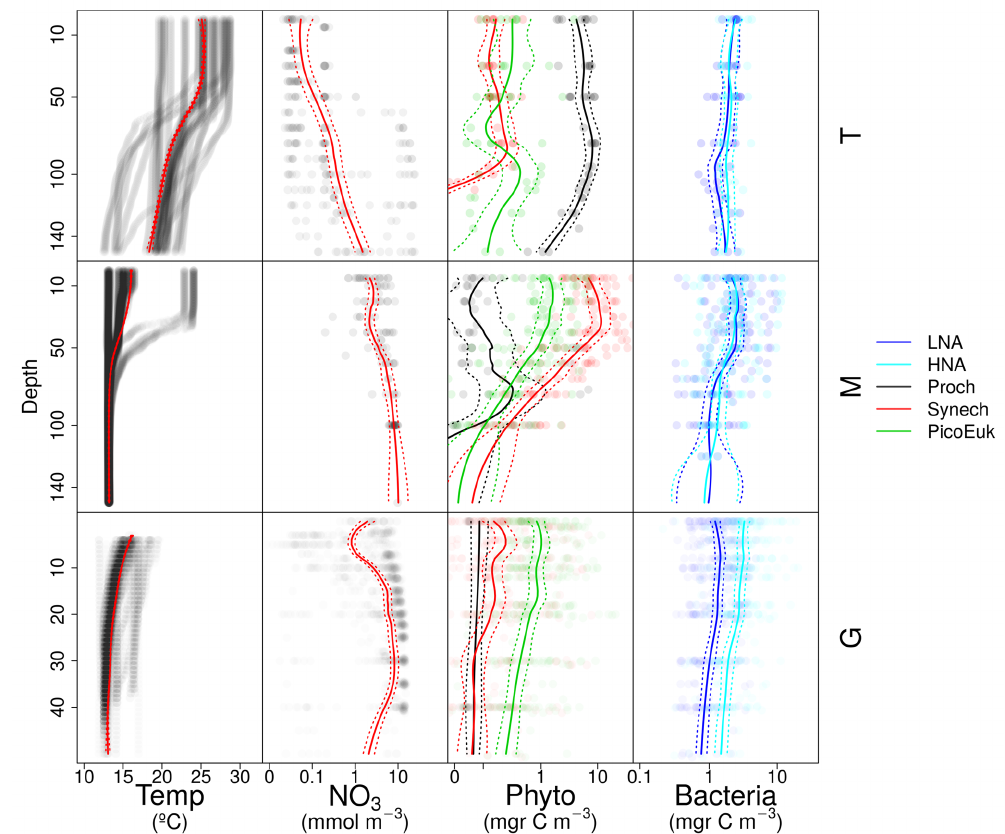
Figure A3. Vertical distribution of temperature (Temp), nitrate (NO 3 ), and picoplankton biomass of autotrophic (Phyto) and heterotrophic (Bacteria) groups for each domain: tropical and subtropical Atlantic Ocean (T), the Mediterranean (M), and the Galician coastal upwelling (G). Points represent raw data and the solid line the locally weighted scatter plot smoothing (LOESS). Dashed lines indicate 95% confidence intervals. Dot and line color intensity indicates the number of overlapping